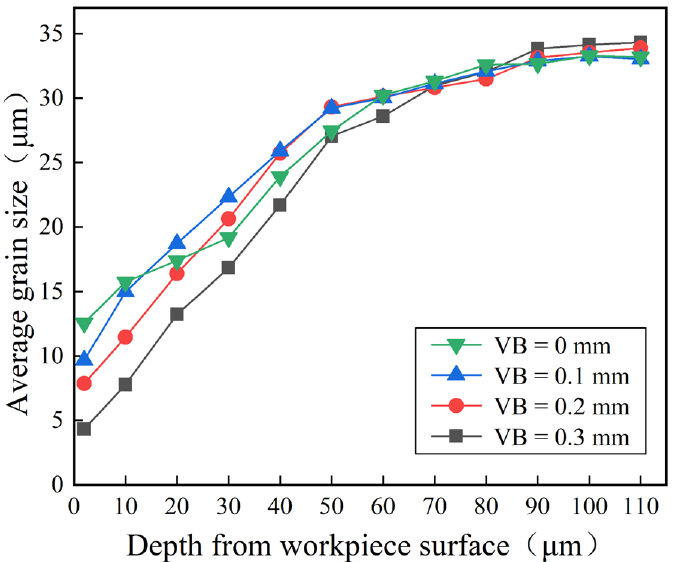
Figure 15. Statistics of the average grain size distribution in the depth direction in the cross-section of the GH4169 workpiece.